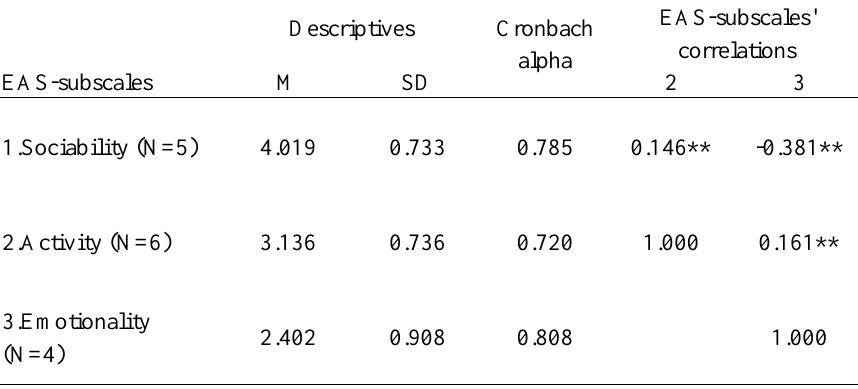
Descriptives: Means (M), Standard deviations (SD), reliability coefficients Cronbach Alpha and Spearman correlation coefficients and significance levels for three